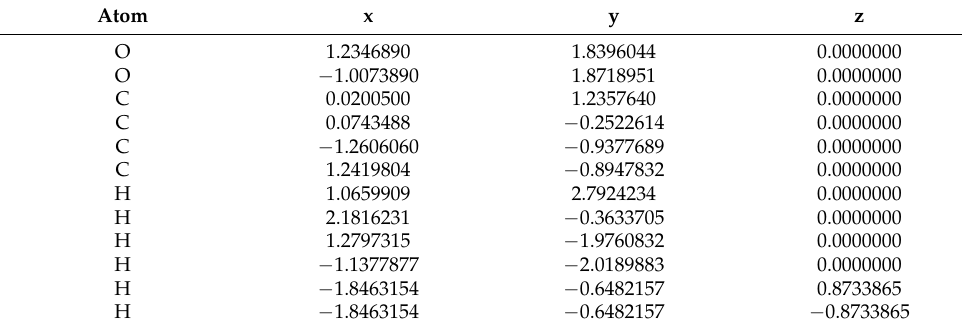
Table A3. Optimized geometry of the trans-chain (TC) conformer.